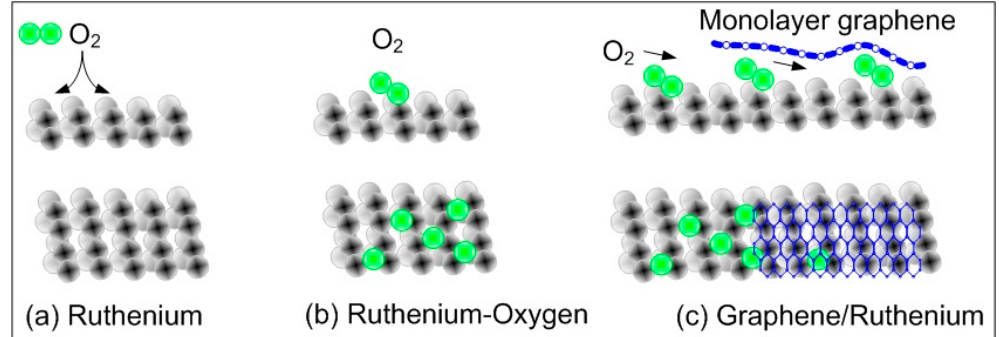
Figure 5. Depositions of oxygen and graphene on Ru surface.